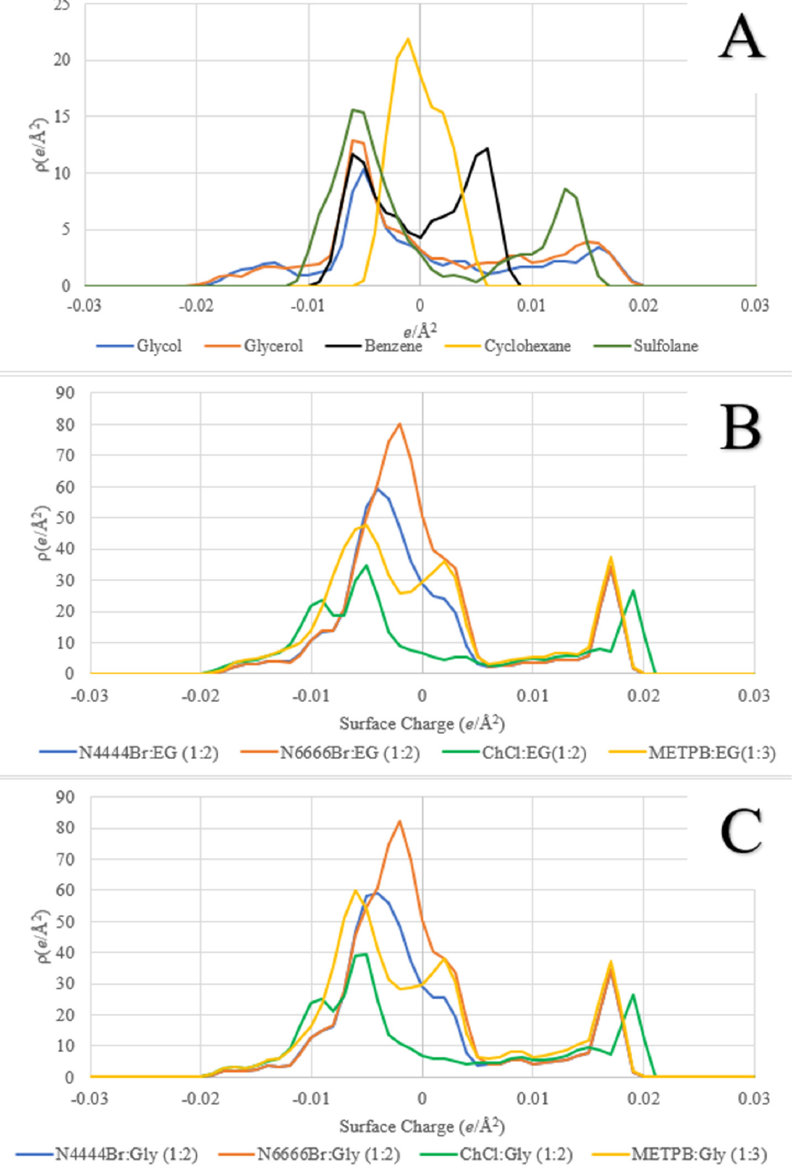
Figure 1. Sigma Profiles of ( A ) Pure Solvents and Solutes ( B ) Ethylene Glycol Based DES and ( C ) Glycerol Based